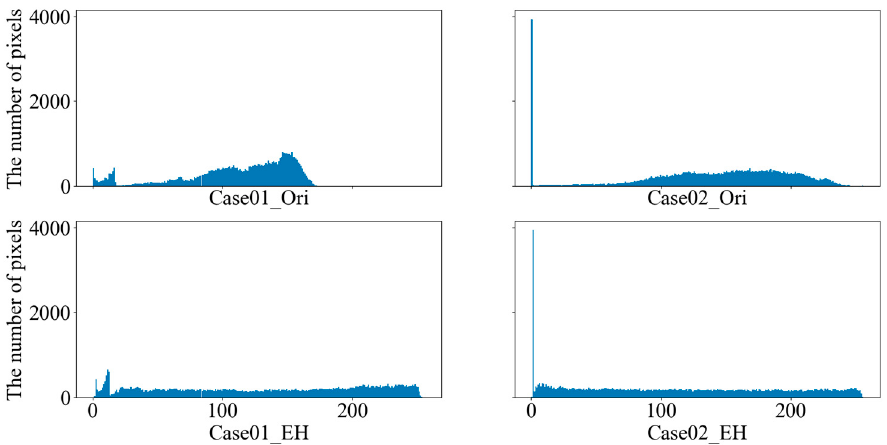
Figure 3. Histogram comparison between original and enhanced images. Ori means original images and EH means images enhanced by DHE. As shown, the scopes of image pixel levels are extended, which means the contrast of images is enhanced effectively.